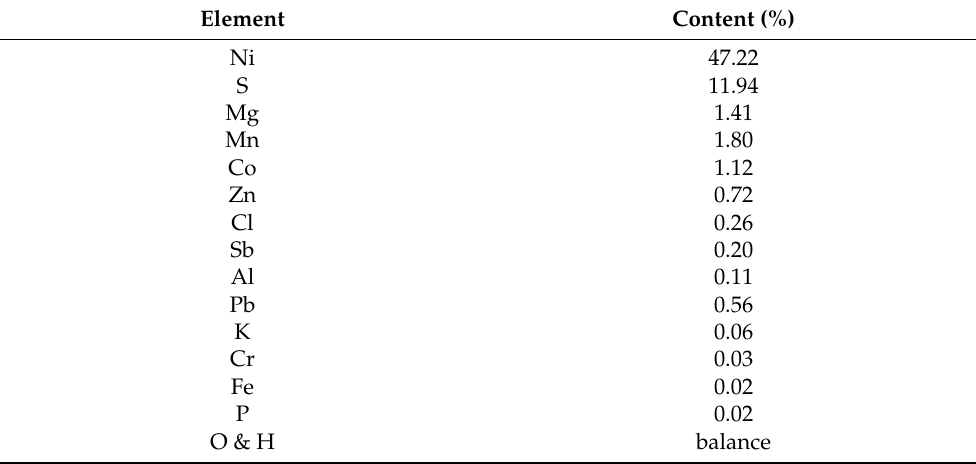
Figure 1. The products of the sintering processes were ground and sieved by a 200-mesh screen and then characterized by the FTIR, XRD, SEM, and particle size analyzer (PSA) analyses. The sintering product of the Li-NMC-oxide sample that used MHP as the initial source of nickel was labeled by SM-LNMCO-811, while the one that used nickel sulfate as the initial source of nickel was labeled by SX-LNMCO-811. Table 1. The chemical composition of MHP used as the source of nickel for the synthesis of the NMC 811 cathode precursor.